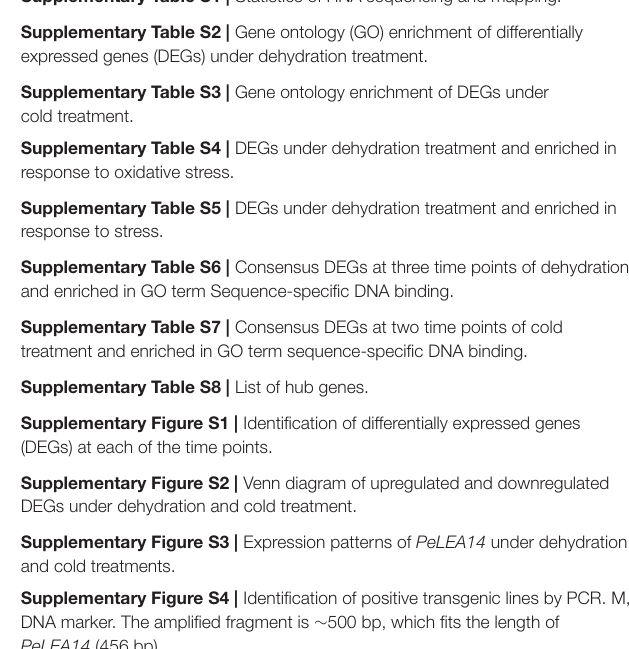
Supplementary Table S1 | Statistics of RNA sequencing and mapping.